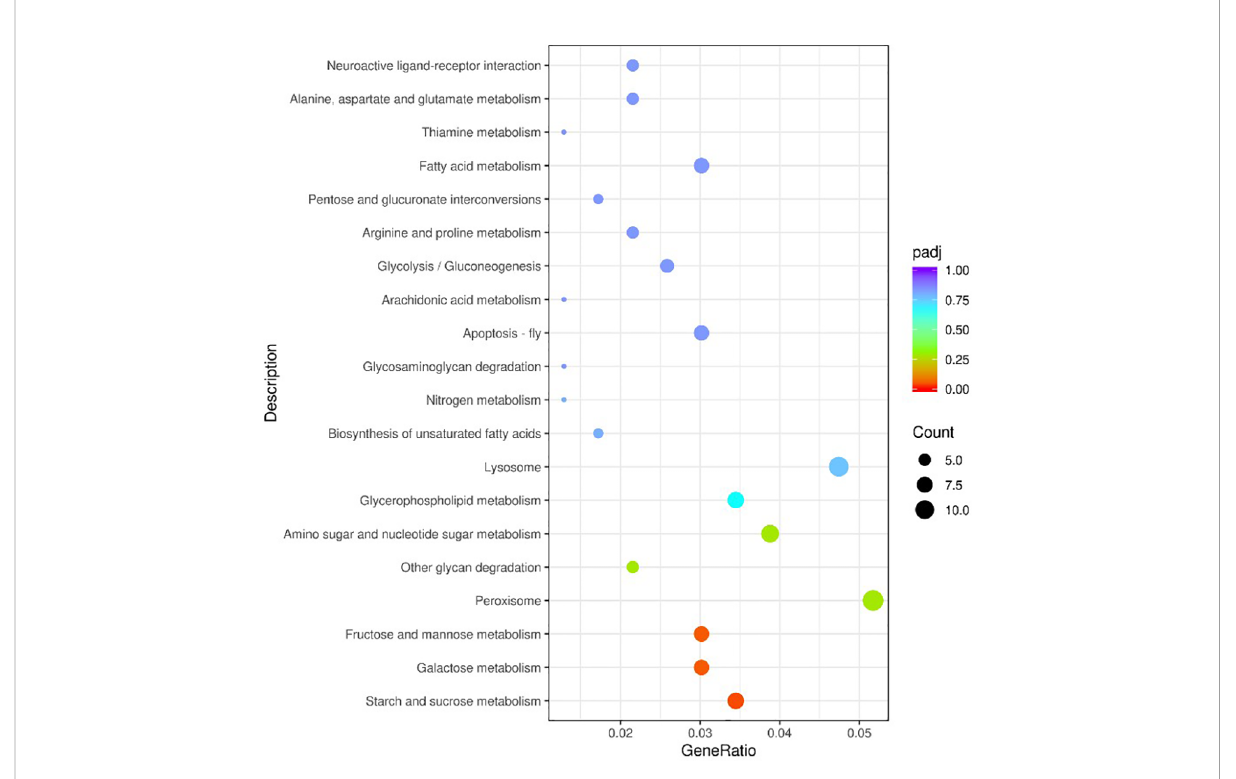
FIGURE 4 KEGG enrichment analysis for the common